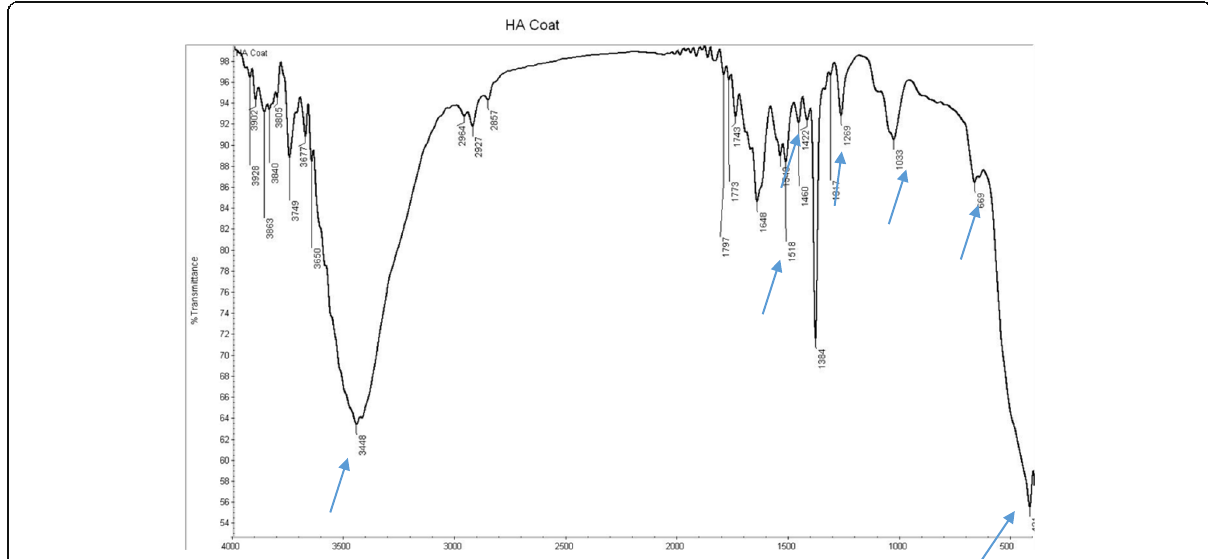
Fig. 3 IR spectra of HA-Zn powder scrapped from coated titanium specimen